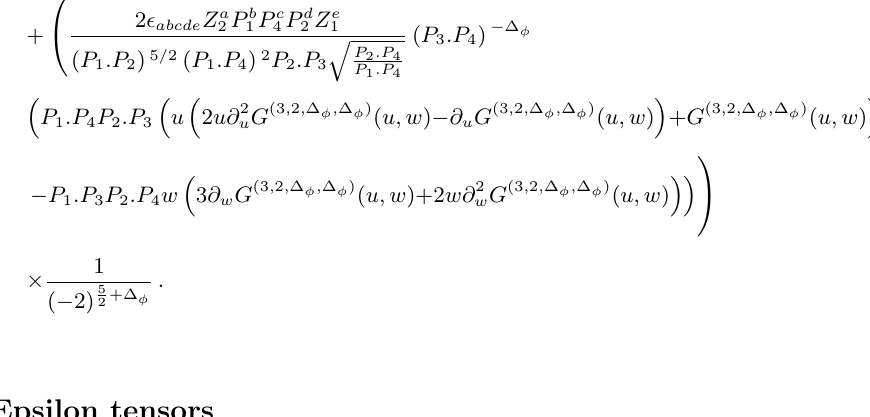
For polarisations corresponding to h j + j x (cid:30)(cid:30) i